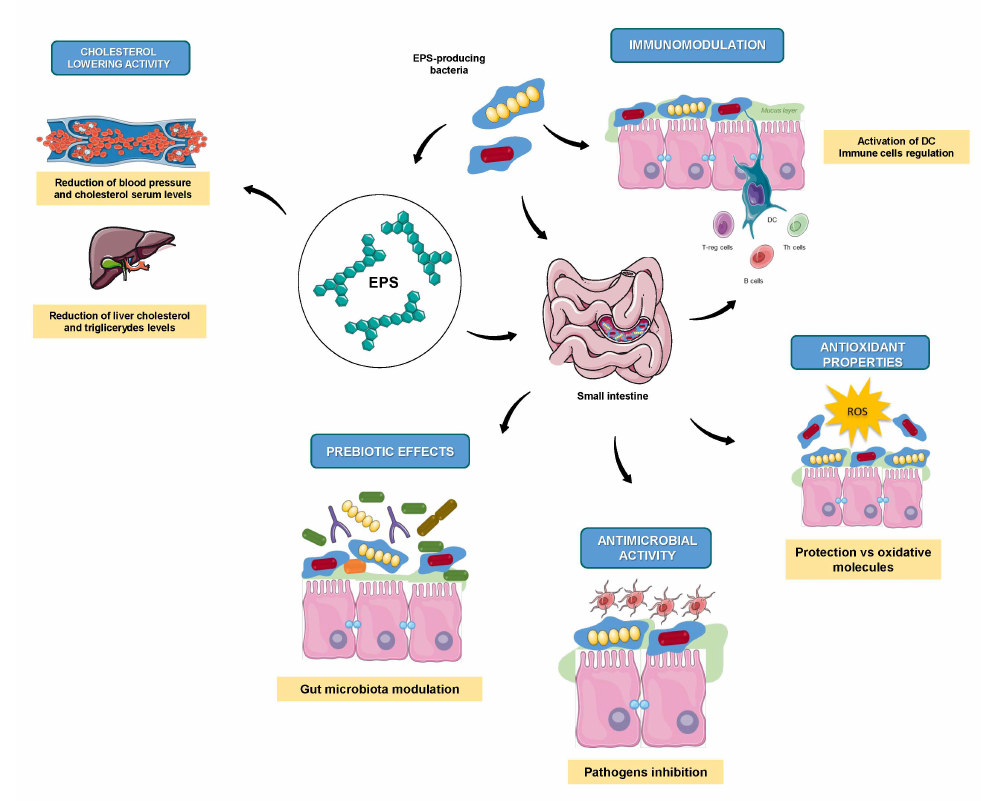
Figure 3. Principal health benefits of EPS produced by LAB strains. Graphical illustrations were created by using some graphical items from Servier Medical Art by Servier, available on https: //smart.servier.com/ (accessed on 15 January 2021) under a Creative Commons Attribution 3.0 Unported